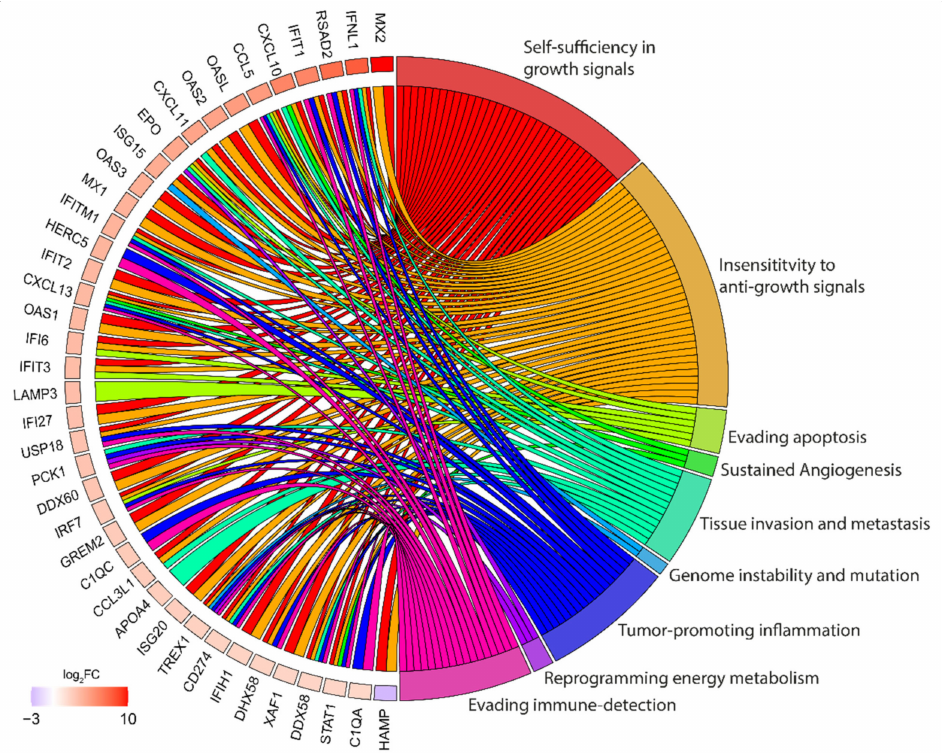
Figure 3. GO cluster plot showing a chord dendrogram of the clustering of the expression spectrum of significantly deregulated genes. Gene ontology identifiers were retrieved from Chen et al. [106] and transcriptome data were provided by Todt et al. [105]. Only transcripts that were deregulated at least four-fold were plotted. Color code represents the logarithmic fold-change (log 2 FC) of mRNA expression in HEVcc-infected PHHs compared to uninfected cells at 48 h post-infection with HEVcc. Gene identifiers for transcripts with absolute log 2 FC ≥ 2, RPKM ≥ 0.5 were used as the input for identification of significantly enriched GO